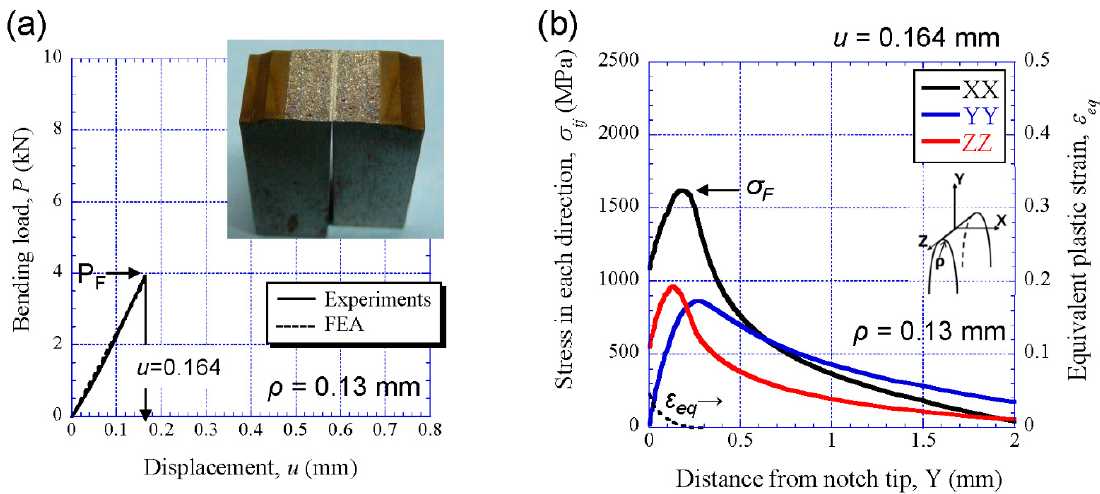
Figure 8. ( a ) Comparison between the P - u relations in the SM18 specimen and the appearance of the sample. ( b ) Distributions of the stresses and the equivalent strain ε eq near the initial notch tip at u = 0.164 mm obtained via FEA.